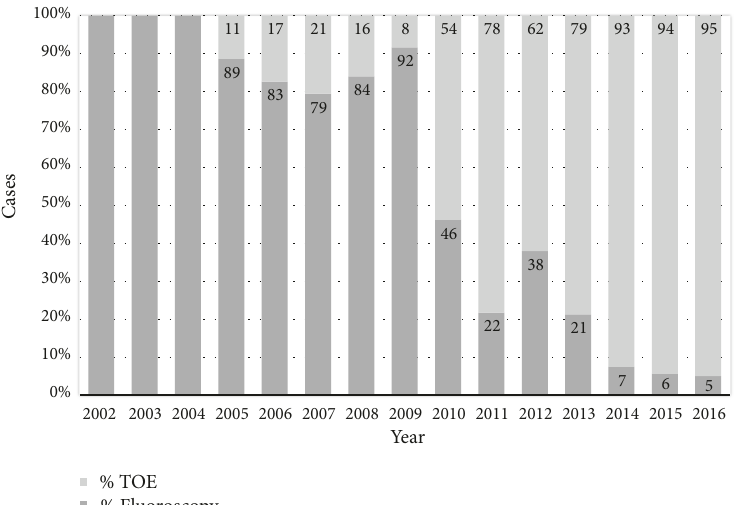
Figure 1: Development of the proportion of interventions performed with TOE guidance only or under fluoroscopy guidance in relation to all cases per year. Significant increase of TOE only guided interventional ASD device closures over the last years. TOE = transoesophageal